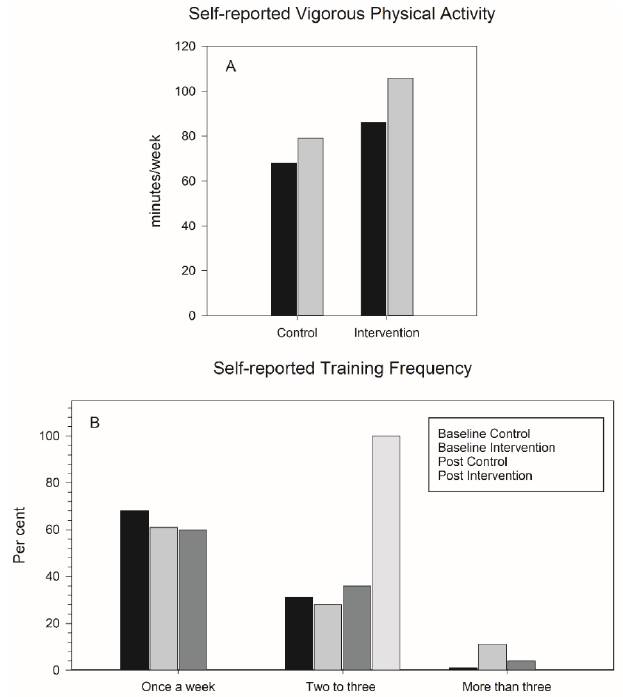
Figure 2. Self-reported change in VPA ( A ), self-reported training frequency ( B Figure 2. Self ‐ reported change in VPA ( A ), self ‐ reported training frequency ( B ). Self ‐ reported training frequency changed during the intervention. At baseline, a majority of the participants trained one or less than one session per week. After the intervention, all members (100%) of the intervention group reported training two to three times a week. The control group members reduced the number that trained one or less than one time per week after intervention and increased the numbers that reported training two or more times per week. Self ‐ reported weekly VPA increased by 11.4 (83.2) min in the control group and 15.6 (116.1) min in the intervention group (Figure 2A and B). We had technical problems evaluating the PAI results, but the intervention group reached an average of 100 PAI per week during the intervention period, statistically significantly more than that of the control group (results not shown).